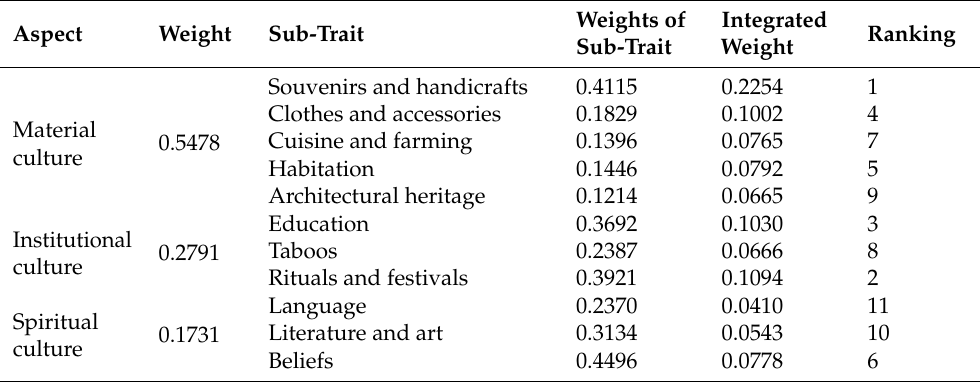
Table 2. Weights of aspects and